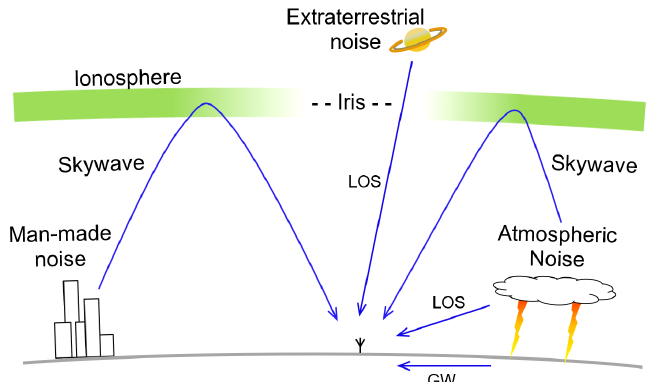
Figure 4. Propagation of HF electromagnetic ambient noise to a remote rural location. LOS = line-of-sight, GW = ground wave. Picture adapted from [24].